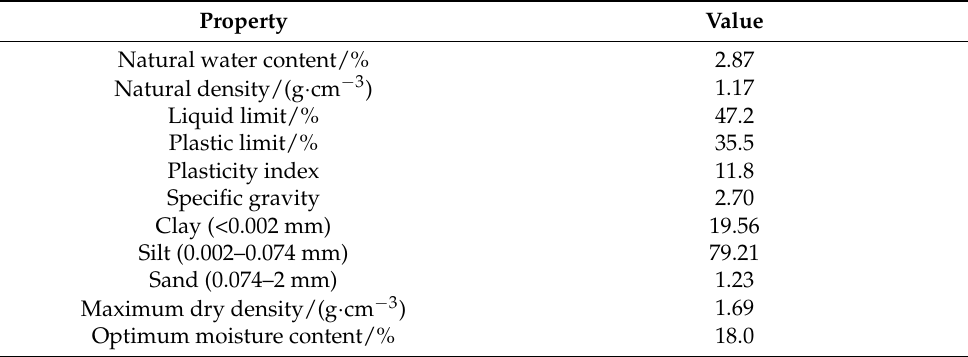
Table 1. Fundamental physical indexes of tested loess.